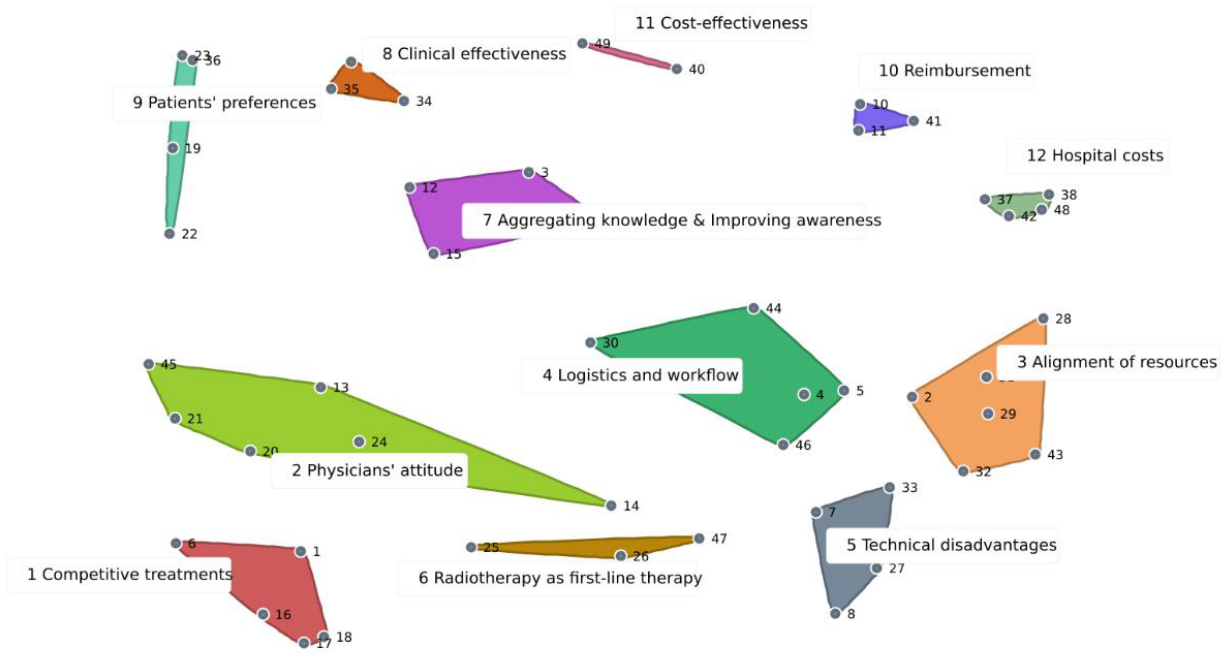
Figure 2. Cluster Map. Statements are numbered and represented by dots. The closer the statements are to each other, the more often they were sorted together by participants. Table 2. Representative statements for each